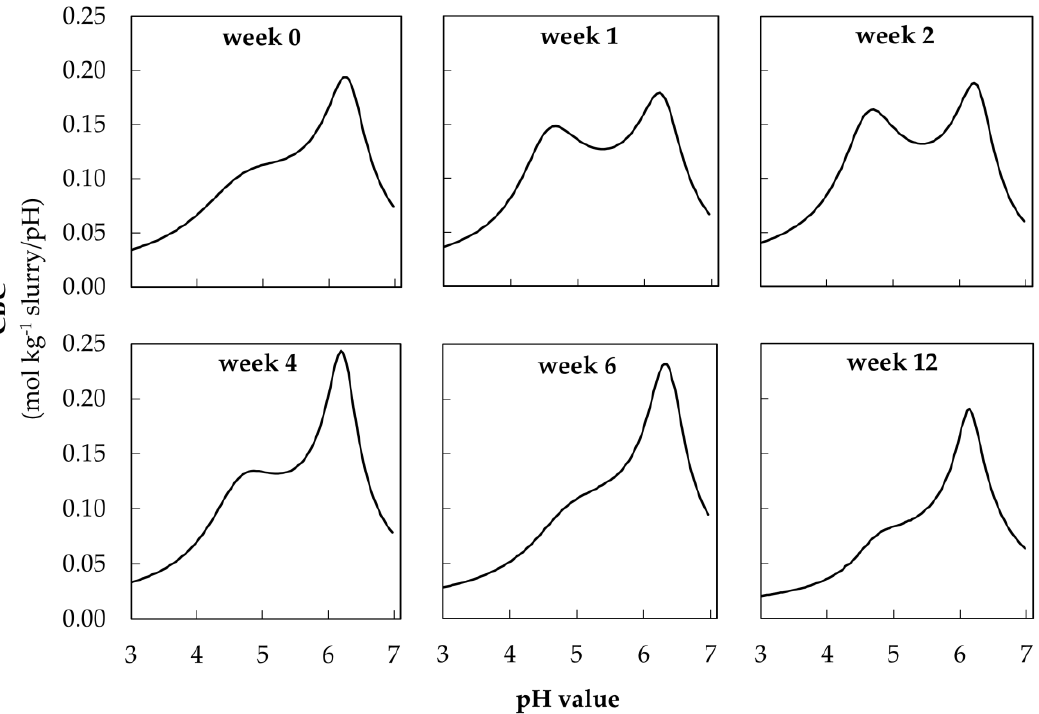
Figure 6. Visualization of CBC depending on pH value in fattening pig slurry stored under warm conditions (23.6 ± 2.1 °C) from week 0 to 12.